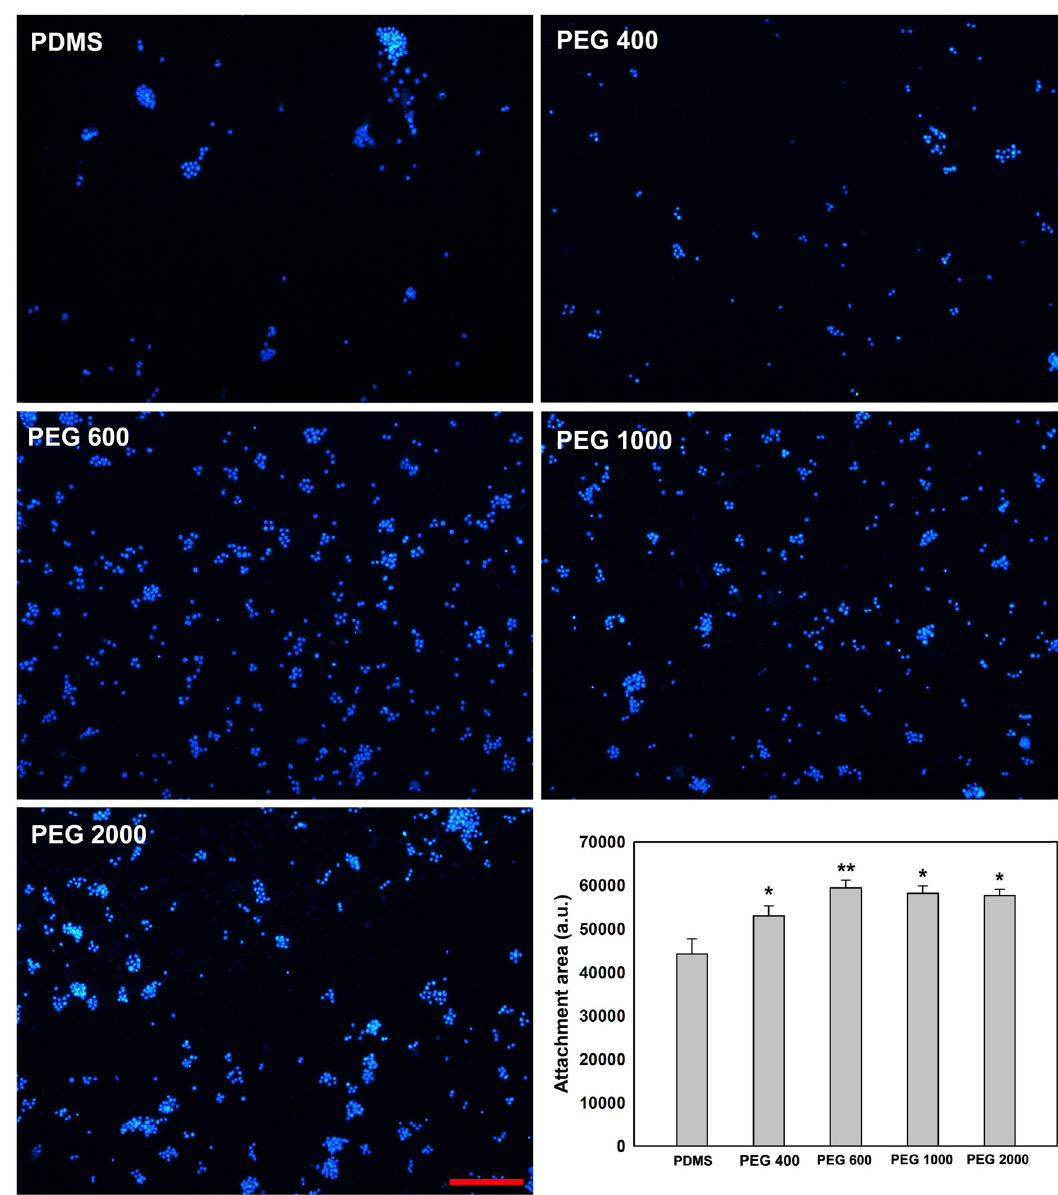
Fig. 5 Representative cell adhesion images of PC12 cells stained by DAPI, cultured on PLL-coated PDMS and PDMS-PEG-PLL with PEG at various molecular weights after PBS rinses. The fi gure in the right bottom corner shows statistical PC12 cell adhesion area on PDMS and